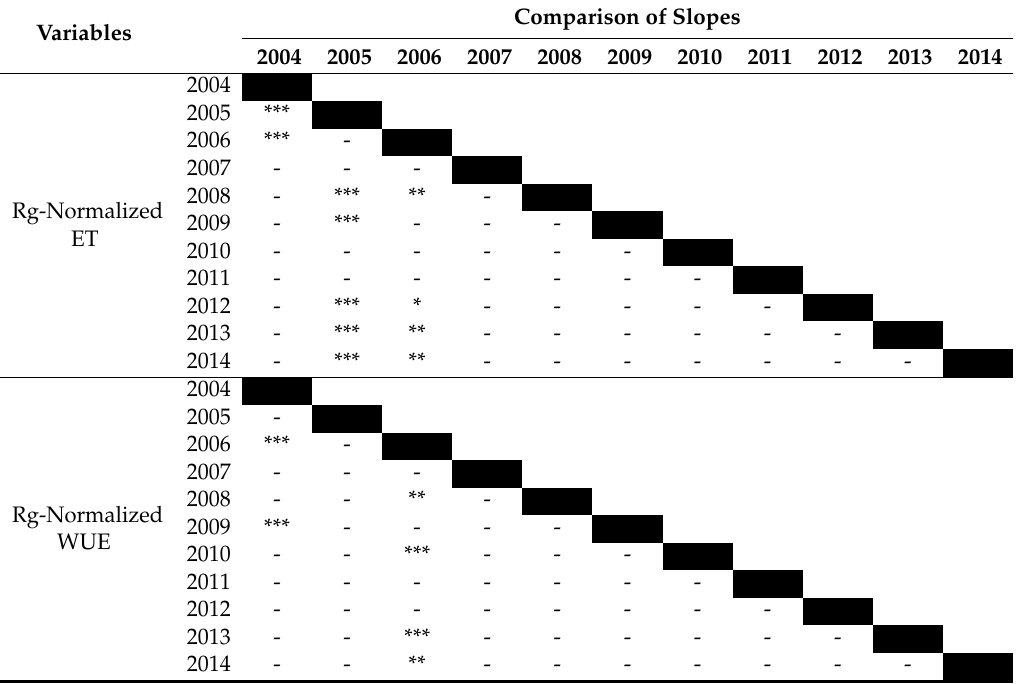
Table A2. Comparison of slopes of Rg-Normalized ET or Rg-Normalized WUE and the soil water stress index (SWSI) for each year from 2004–2014 based on standardized major axis (SMA) regression analyses.